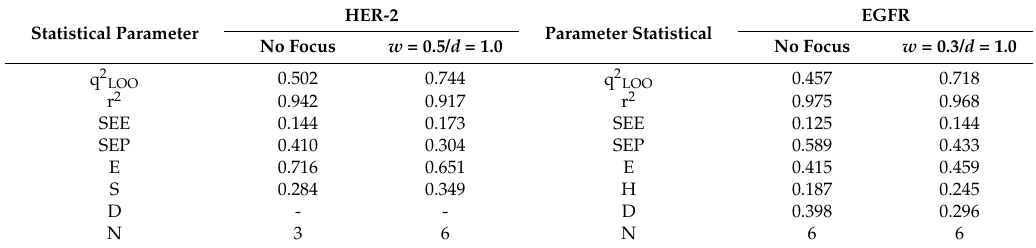
Table 3. Results for the best CoMSIA model (HER-2 and EGFR) using no focus and focus techniques. HER-2 Statistical Parameter Parameter Statistical w = 0.5/ d = 1.0 w = 0.3/ d =